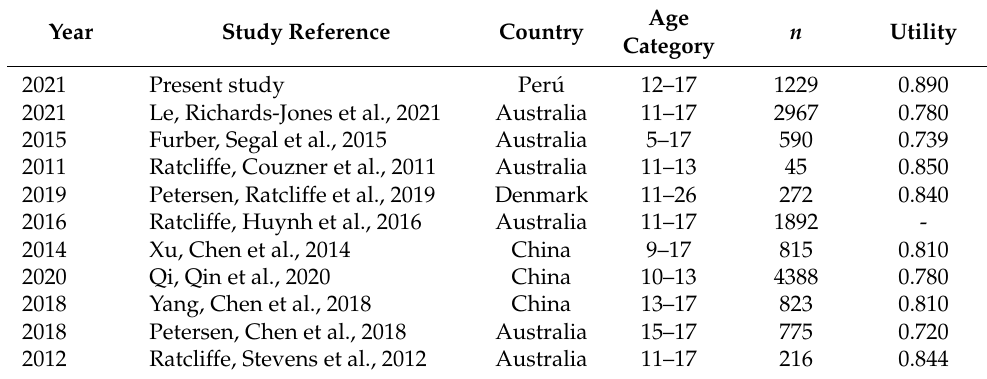
Table 5. Studies reporting on adolescents’ perceived good quality of life using the CHU9D